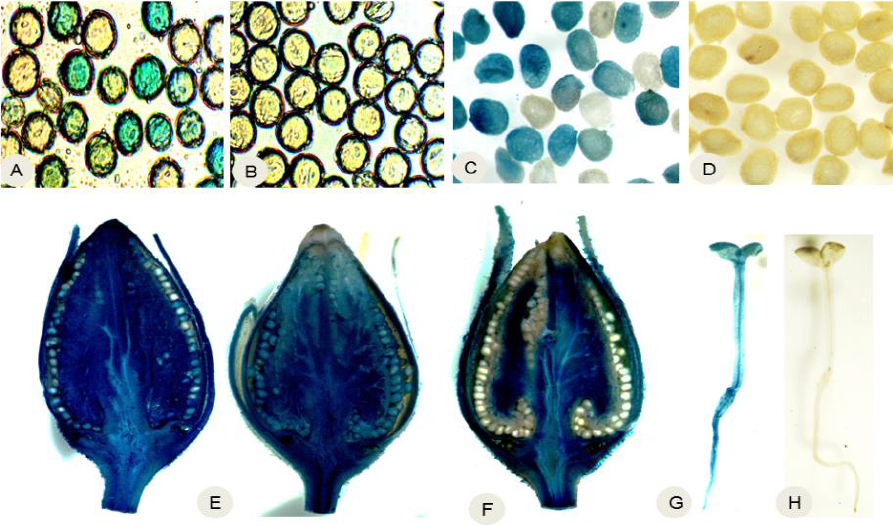
Figure 2. Detection of transgene deletion. ( A ) GUS-stained mature pollen grains produced by control transgenic line C1, showing GUS activity (blue staining) in about half of the pollen grains. ( B ) GUS-stained mature pollen grains produced by transgenic line D4 carrying the ‘pollen- and seed-specific Gene Deletor’ cassette, showing that no pollen grains had GUS activity. ( C ) GUS-stained immature seeds collected from the fruits of line C1 at 18 days after pollination (DAP), showing that some seeds had GUS activity. ( D ) GUS-stained immature seeds collected from the fruits of line D4 at 18 DAP, showing that no seeds had GUS activity. ( E ) GUS-stained sections of an immature fruit produced by line C1 at 18 DAP; many seeds show GUS activity. ( F ) GUS-stained half-section of the immature fruit (18 DAP) produced by line D4, showing white seeds (i.e., without GUS activity) attached to blue tissues (i.e., GUS positive). ( G , H ) GUS-stained self-pollinated T1 seedlings produced by ( G ) line C1 and ( H ) line D4. Scale bar = 20 µM.